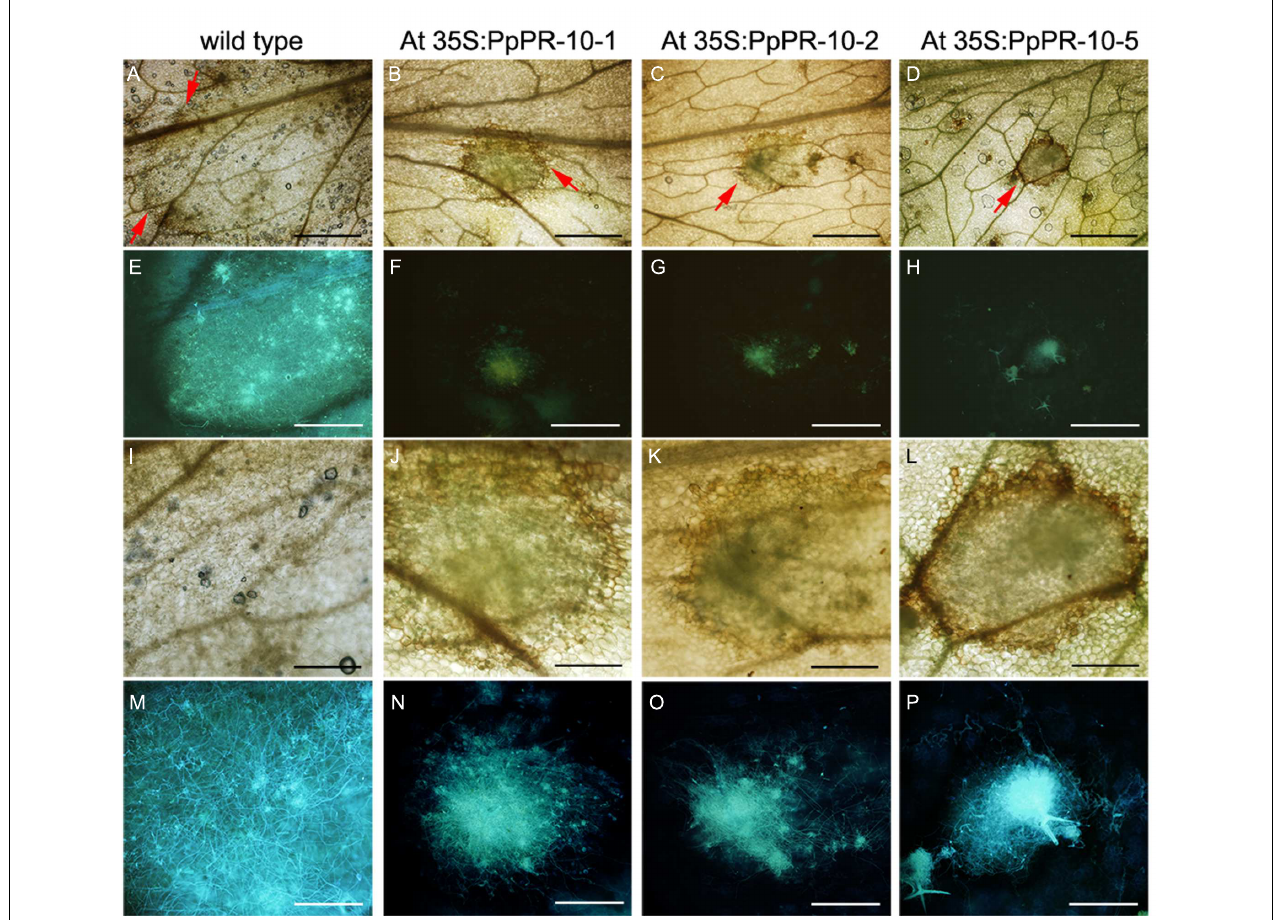
FIGURE 9 | Pythium irregulare infected Arabidopsis wild type and overexpressing PpPR-10 lines. Symptom development in 2 days-inoculated Arabidopsis leaves of wild type (A) , At 35S:PpPR-10-1 (B) , At 35S:PR-10-2 (C) , and At 35S:PR-10-5 (D) . Red arrows indicate the border of the lesions. Hyphae in the infected tissues were visualized using the fluorescent dye solophenyl flavine in wild type (E) , At 35S:PpPR-10-1 (F) , At 35S:PR-10-2 (G) , and At 35S:PR-10-5 (H) . Magnification of the same pictures as in (A–G ) are shown in (I–P) , respectively. Scale bars represent in (A–H) ; 1 mm and in (I–P) ; 0,3